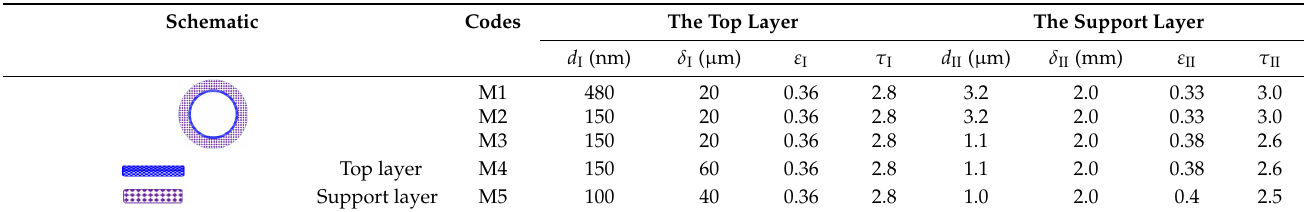
Table 2. Structure parameters of five hydrophobic asymmetric membranes. Schematic